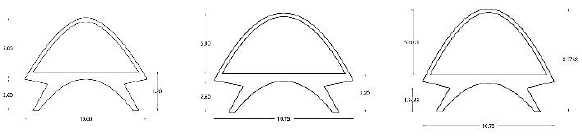
Figure 4. Cordero's comparison diagram of the 3 phases of the building: Left: Structural Memory, Center: Architectural Drawings, Right: Architectural Survey